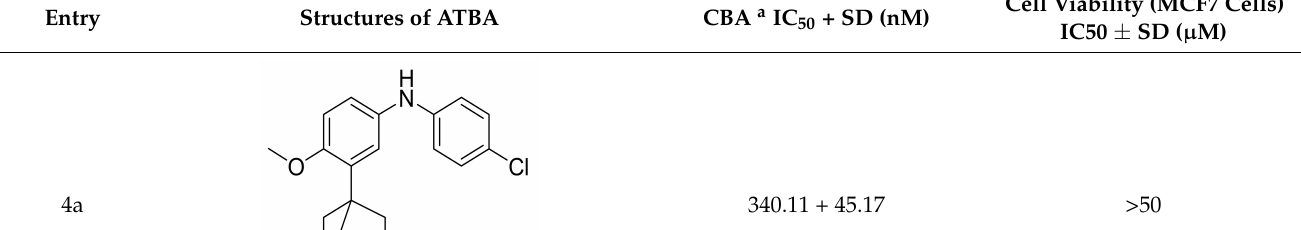
Table 1. Competitive binding affinity of ATBA molecules to ER α and their functional effect on MCF7 cells. Entry Structures of